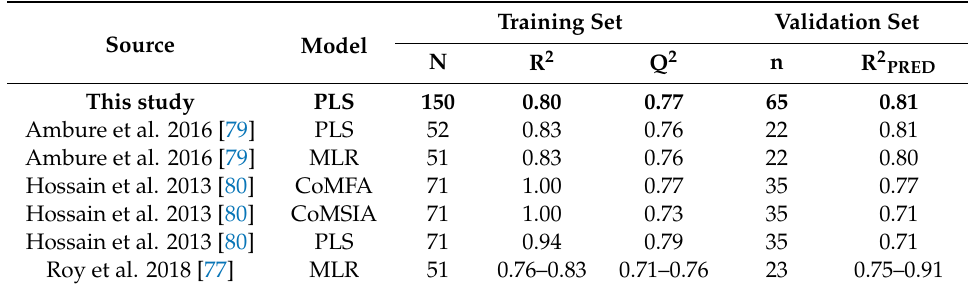
Table 5. Comparison of this study with previous published works on 2D-QSAR model for BACE1.